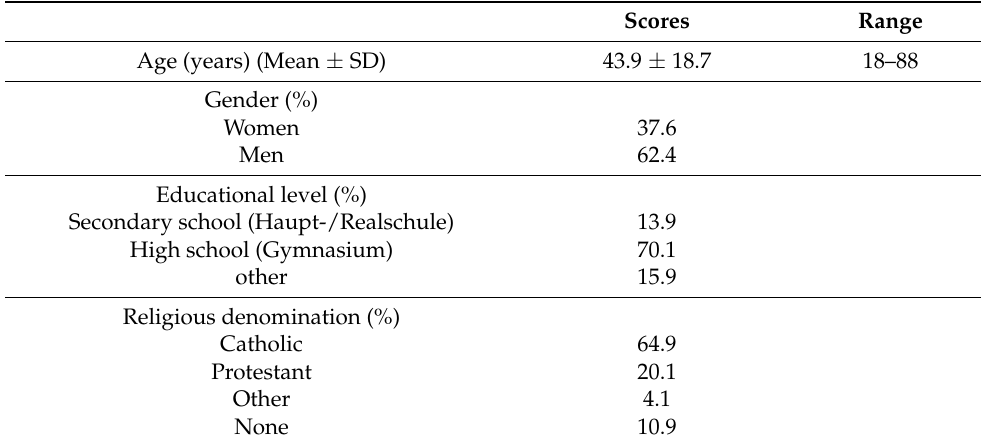
Table 1. Description of the sample (N =